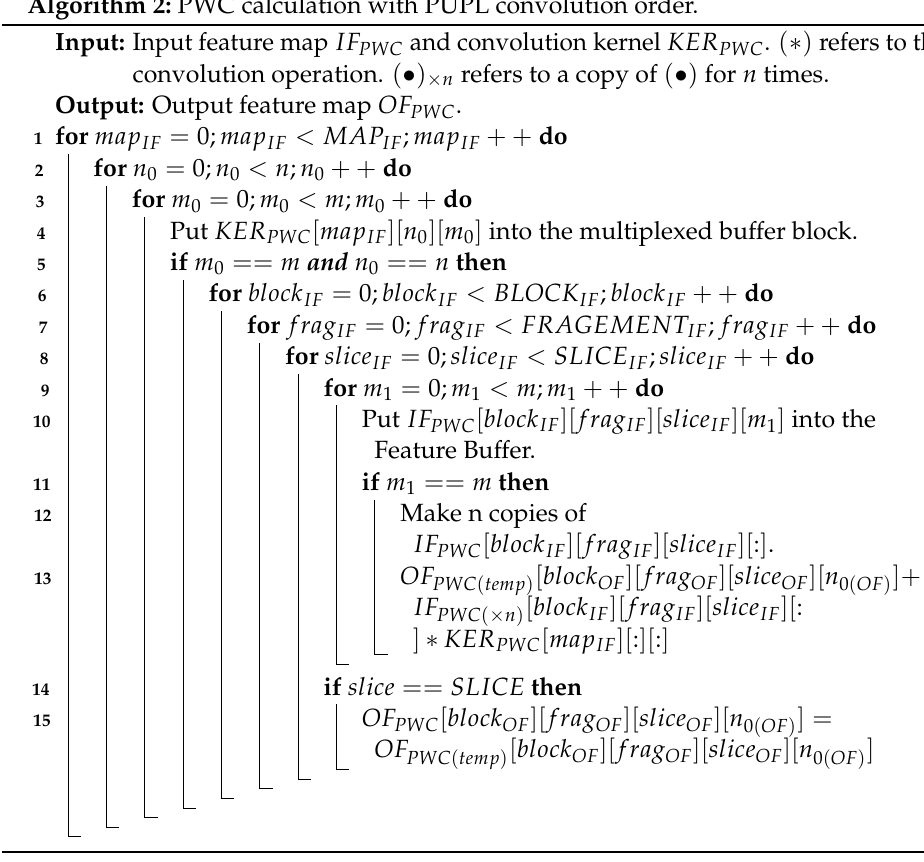
Algorithm 2: PWC calculation with PUPL convolution